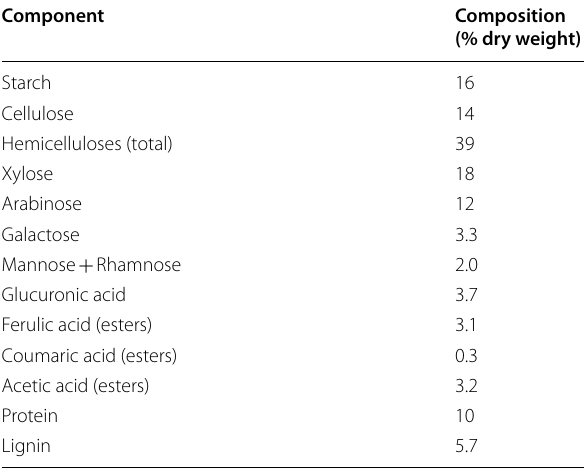
Table 1 Chemical composition (%) of corn fiber (Eylen et